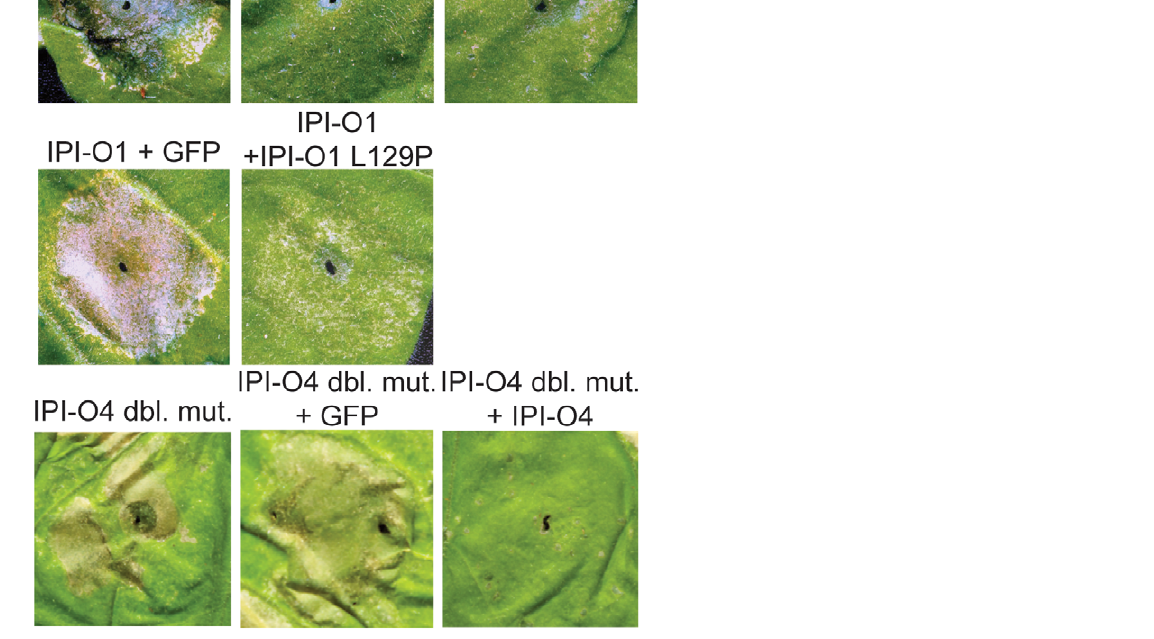
Figure 5. Suppression of hypersensitive cell death of IPI-O1 by IPI-O1 L129P and IPI-O4 P129L/G135S (double mutant) by IPI-O4. A. tumefaciens strains expressing the indicated IPI-O variants or a GFP control were infiltrated or co-infiltrated into leaves of RB transgenic N. benthamiana plants. Leaves were photographed at 6 days after infiltration.